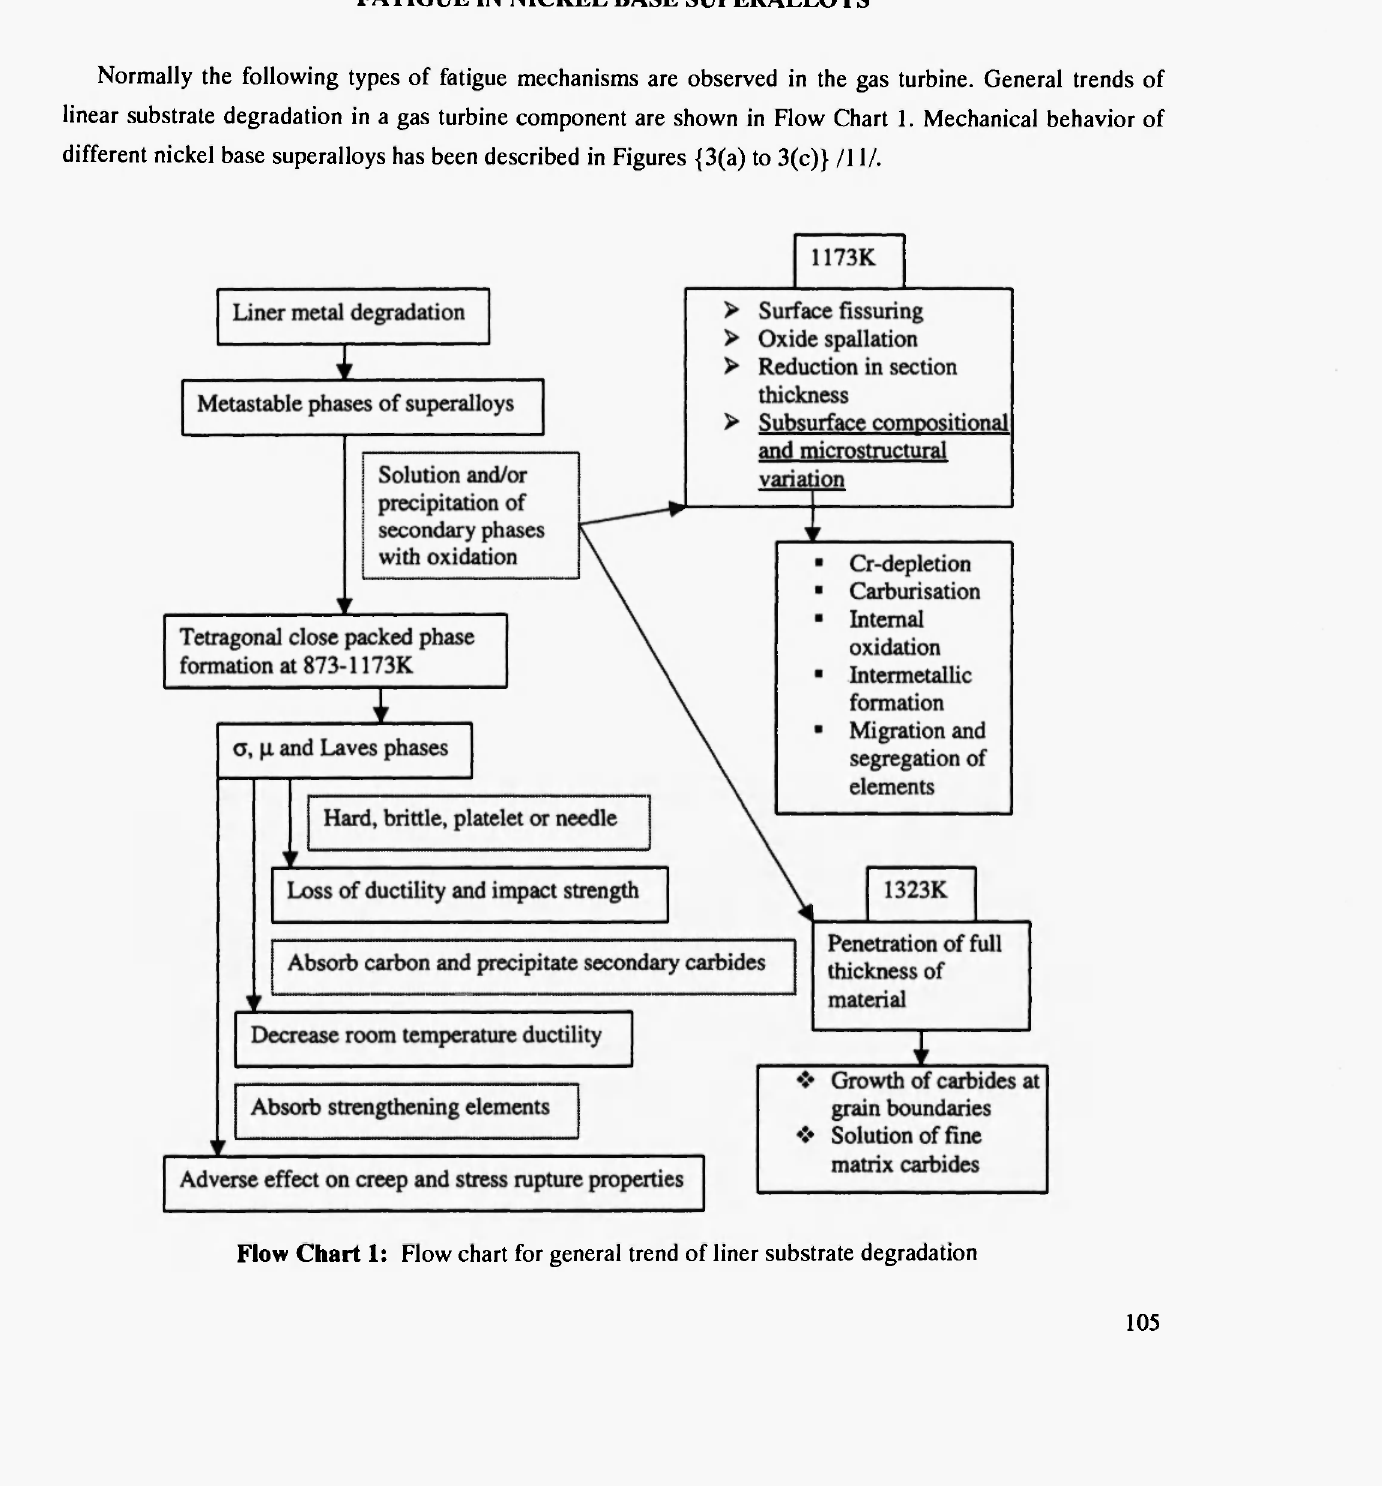
Flow Chart 1: Flow chart for general trend of liner substrate